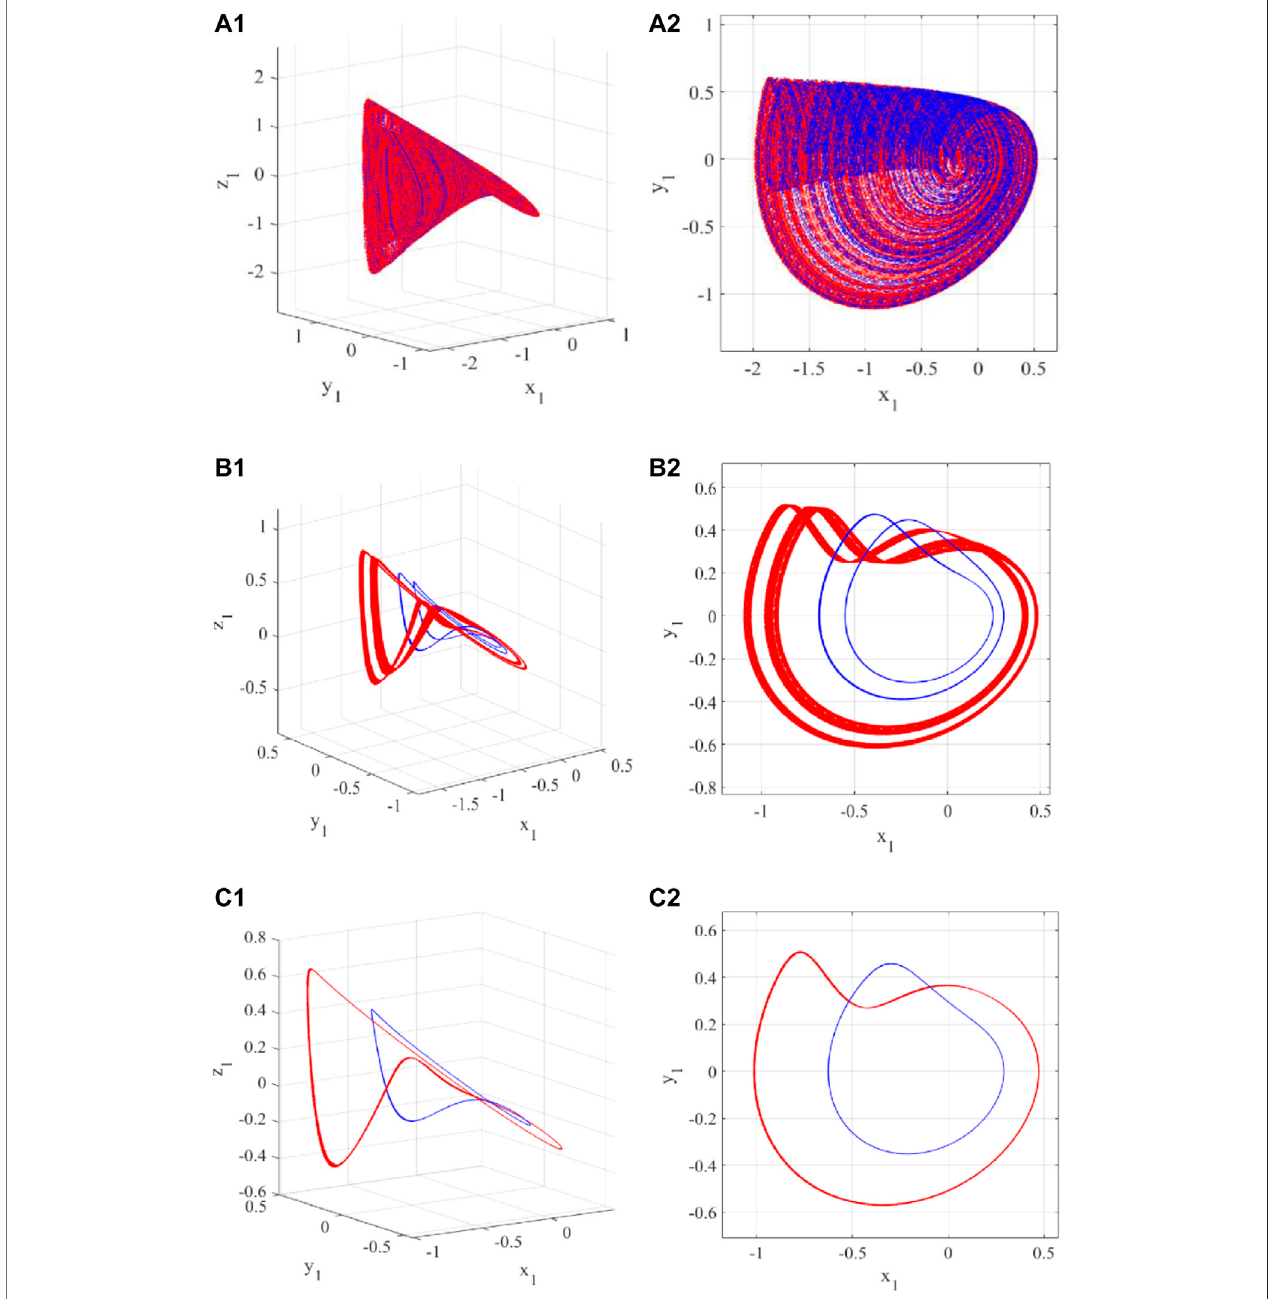
To better clarify the variable-boostable phenomenon, different k was selected to plot the phase diagrams. For the dimensionless system (13), the fi xed time step of 0.001 was used for numerical simulations. The projections of attractors in the x-y plane are given in Figures 5A,B , where the blue, red, and yellow orbits correspond to k = 2 for ( x 0 , y 0 , z 0 ) = ( − 2, 0.4, 0), k = 0 for ( x 0 , y 0 , z 0 ) = (0, 0.4, 0),